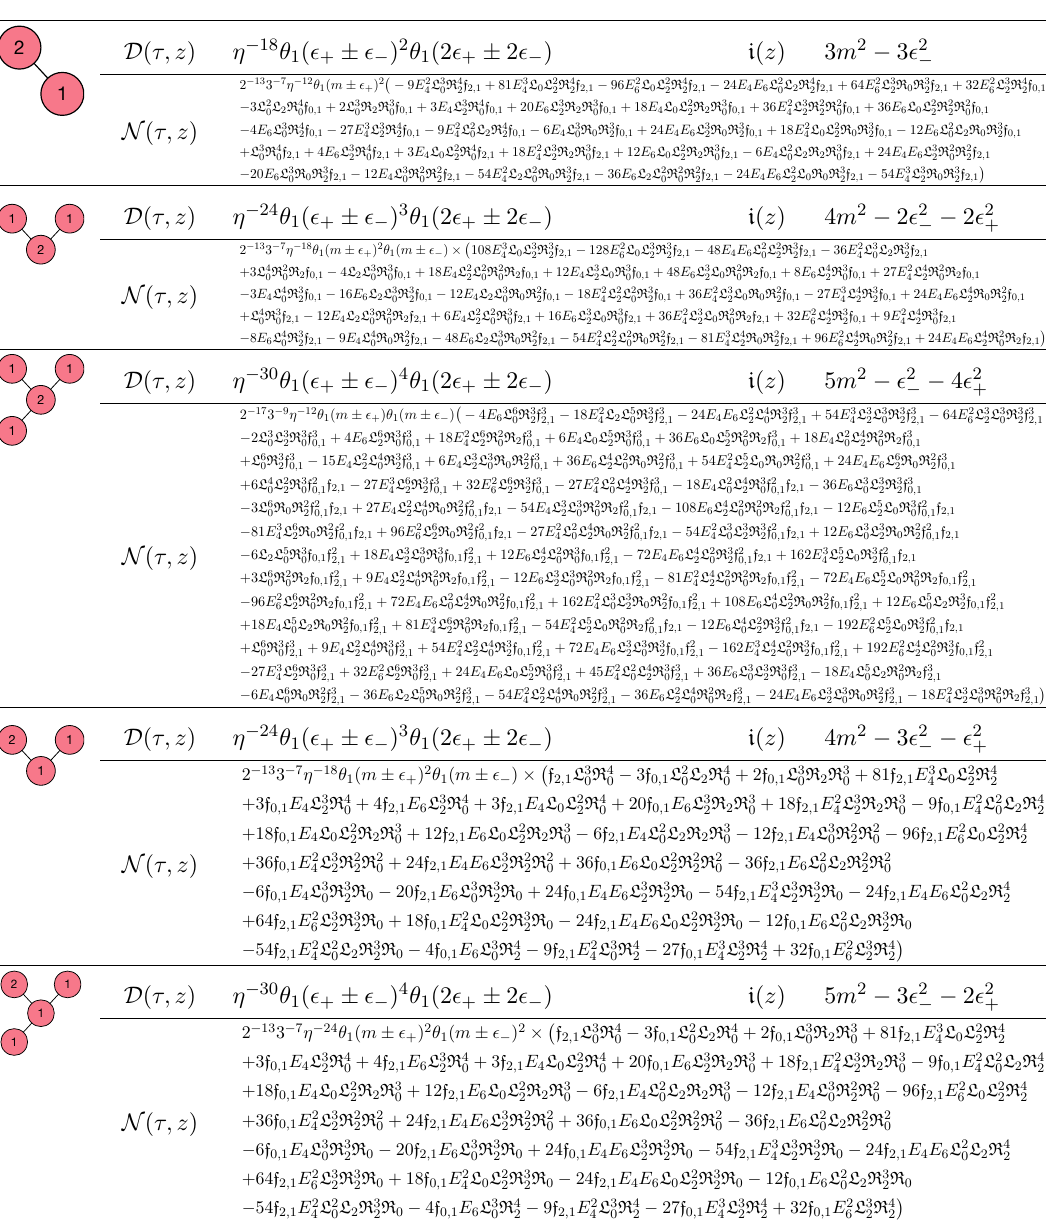
and (cid:22) I 1 0